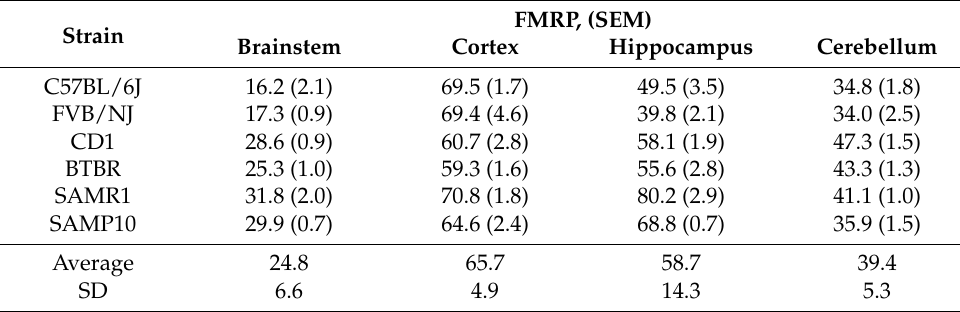
Table 3. FMRP detected by qFMRPm in four brain structures of six mouse strains.